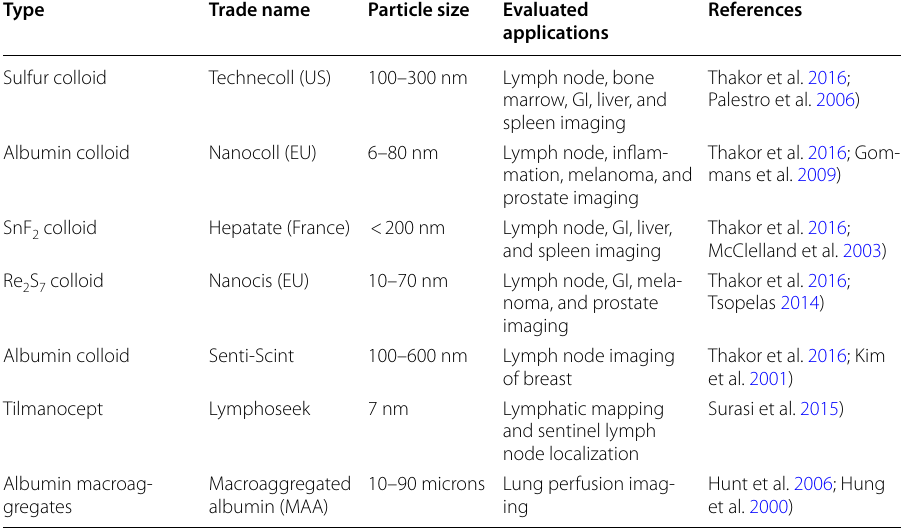
Table 1 Clinically approved 99m Tc‑labeled nanoparticles and microparticles by SPECT